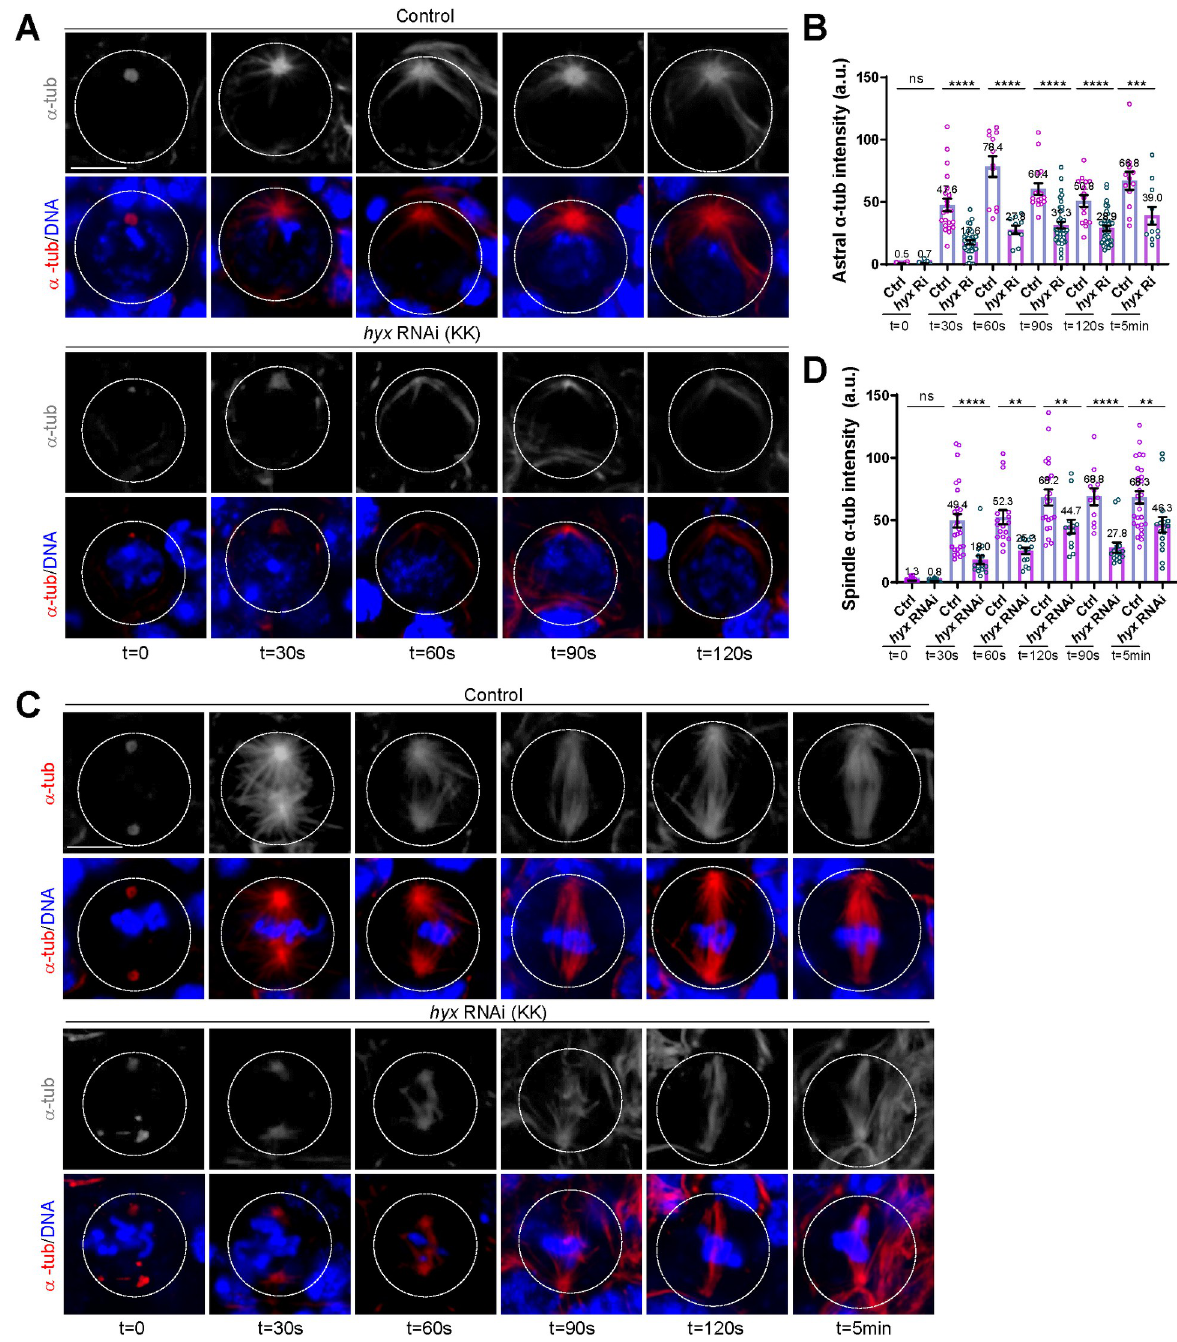
Fig 4. Hyx promotes microtubule growth in NSCs. ( A ) Control ( UAS- β -Gal RNAi) and hyx RNAi (KK/V103555) interphase NSCs were labelled for α -tub and DNA at various time points after recovery from treatment on ice in microtubule regrowth assay. At 0 s (t = 0; ice treatment), no astral microtubules around the centrosome/MTOC were observed in all control ( n = 74) and hyx RNAi NSCs ( n = 63). At all subsequent time points following the recovery, all control NSCs assembled robust astral microtubules (t = 30 s, n = 31; t = 60 s, n = 11; t = 90 s, n = 27; t = 120 s, n = 26). Astral microtubules were lost in hyx RNAi: t = 30 s, 71.9%, n = 43; t = 60 s, 85.7%, n = 7; t = 90 s, 91.2%, n = 46; t = 2 min, 86.3%, n = 63. ( B ) The immunofluorescence intensity of astral microtubules (with SEM) marked by α -tub for various time points in A. Control: t = 0, 0.5 ± 0.13, n = 19; t = 30 s, 47.6 ± 5.01, n = 22; t = 60 s, 78.4 ± 0.13, n = 12; t = 90 s, 60.4 ± 4.58, n = 16; t = 2 min, 50.8 ± 4.65, n = 15; t = 5 min, 66.8 ± 7.27, n = 12. hyx RNAi: t = 0, 0.7 ± 0.22, n = 27; t = 30 s, 17.6 ± 1.73, n = 35; t = 60 s, 27.8 ± 3.27, n = 10; t = 90 s, 31.3 ± 2.60, n = 39; t = 2 min, 28.9 ± 2.04, n = 42; t = 5 min, 39.0 ± 7.07, n = 11. RNAi was controlled by insc -Gal4. ( C ) Control ( UAS- β -Gal RNAi) and hyx RNAi (KK/V103555) metaphase NSCs were labelled for α -tub and DNA at various time points after recovery from treatment on ice in microtubule regrowth assay. Control: t = 0, n = 52;